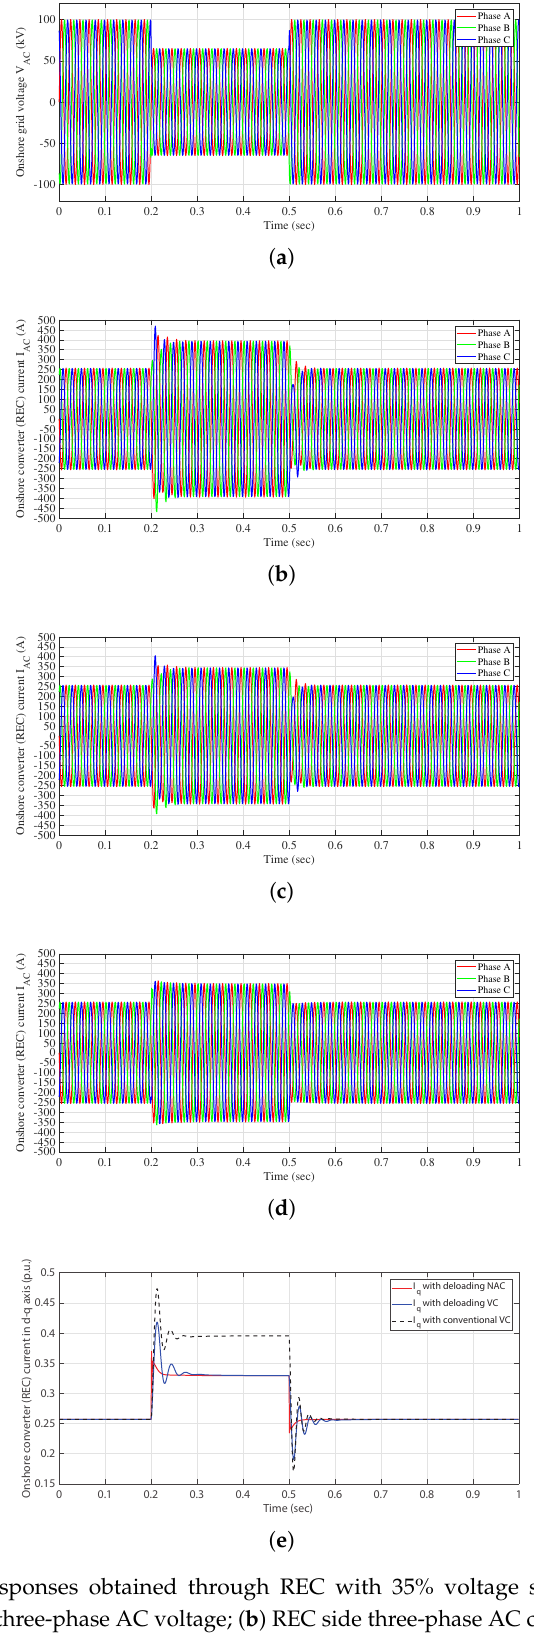
Figure 6. System responses obtained through REC with 35% voltage sag at onshore AC grid. ( a ) Onshore grid side three-phase AC voltage; ( b ) REC side three-phase AC current with conventional VC; ( c ) REC side three-phase AC current with deloading VC; ( d ) REC side three-phase AC current with deloading NAC; ( e ) REC side current in d-q axis with three